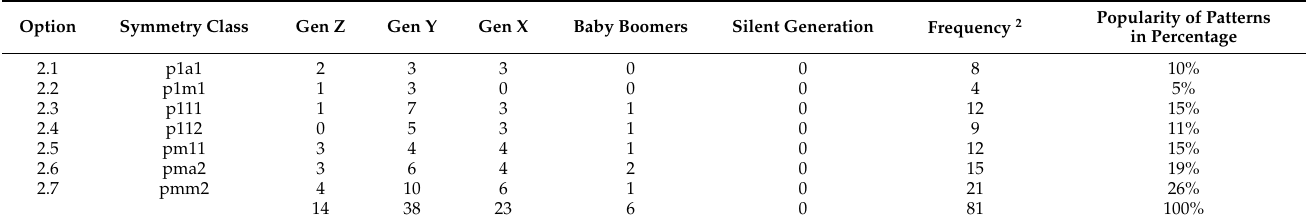
Table 4. Preferences 1 for frieze patterns from design approach